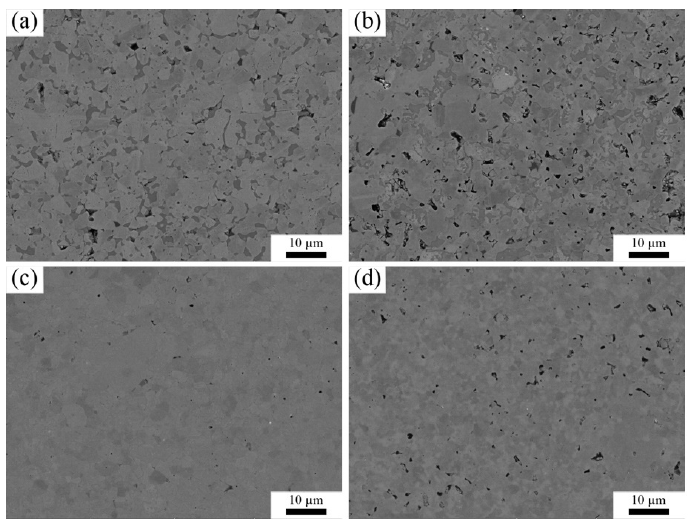
Figure 3. Backscattered electron (BSE) images from the polished surface of the sintered samples. ( a ) ZN, ( b ) ZT10, ( c ) ZT20, ( d ) ZT30.